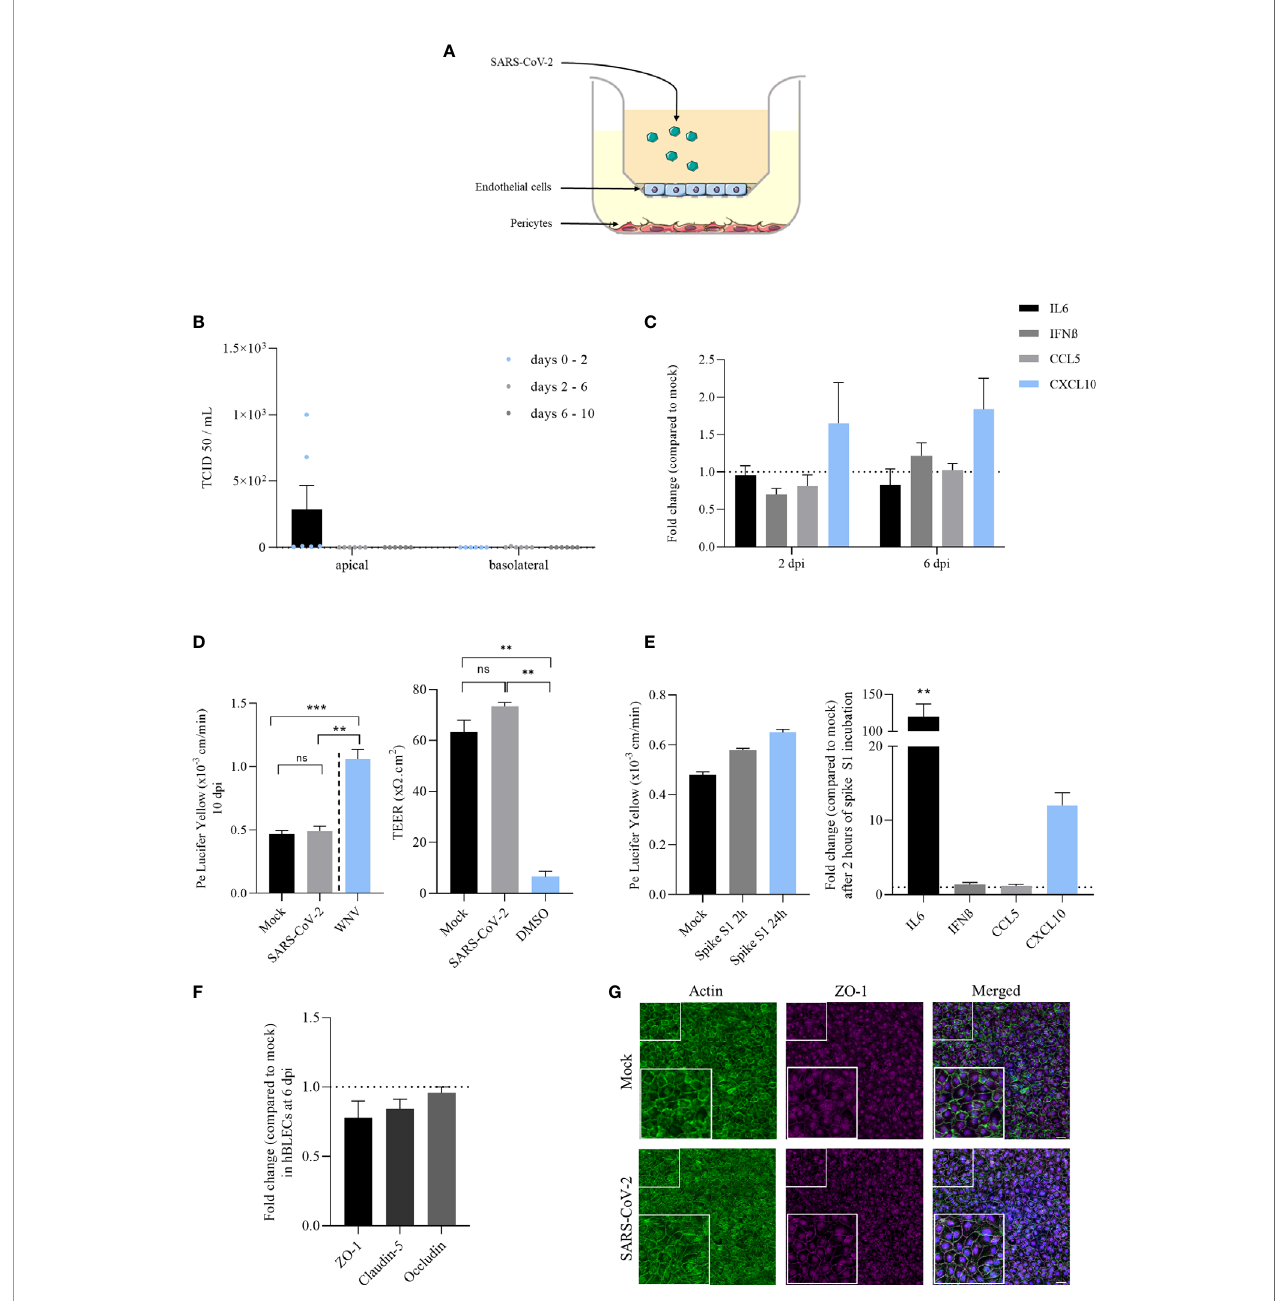
FIGURE 2 | Infection of a human in vitro BBB model by SARS-CoV-2 reveals weak replication, limited induction of in fl ammatory cytokines and did not perturb the speci fi c brain endothelial structure. (A) The in vitro BBB model is composed of primary brain pericytes cultured at the bottom of plastic plates, allowing the differentiation of CD34 + blood cord-derived endothelial cells into human brain-like endothelial cells (hBLECs) on transwell fi lters in the apical chamber. Virus is added in this compartment representing the blood side of the BBB. (B) Replication of SARS-CoV-2 in hBLECs in apical and basolateral compartments at 2, 6 and 10 dpi at MOI 1, titrated by TCID50 measurement on Vero cells. Results are expressed as mean ± SEM. (C) In fl ammatory responses following SARS-CoV-2 infection of hBLECs at MOI 1 expressed in mRNA fold change compared to non-infected cells at 2 and 6 dpi. (D) Permeability coef fi cient of Lucifer Yellow 10 days after infection of hBLECs by SARS-CoV-2 or WNV at MOI 1. Bars show mean of 3 independent experiments ± SEM (n = 6; ns = non signi fi cant, ** p < 0.01 *** p < 0.001); Transendothelial electric resistance (TEER) measures done after 10 dpi on mock- and infected-hBLECs. Positive control of permeable BBB was used by adding 20% DMSO during one hour before measurement. Bars show mean of 3 independent experiments ± SEM (n = 6; ** p < 0.01). (E) Permeability coef fi cient of Lucifer Yellow following 2 or 24 hours after incubation of hBLECs with 10 nM of spike S1 subunit recombinant protein. Bars show mean of 3 independent experiments ± SEM; In fl ammatory responses following spike S1 subunit recombinant protein incubation of hBLECs at 10 nM expressed in mRNA fold change compared to non- incubated cells 2 hours after (n = 6; ** p < 0.01). (F) Tight junction protein mRNA expression following SARS-CoV-2 infection of hBLECs at MOI 1 compared to mock at 6 dpi. (G) Immuno fl uorescence staining of ZO-1 and actin in hBLECs at 10 dpi. Scale bar = 50